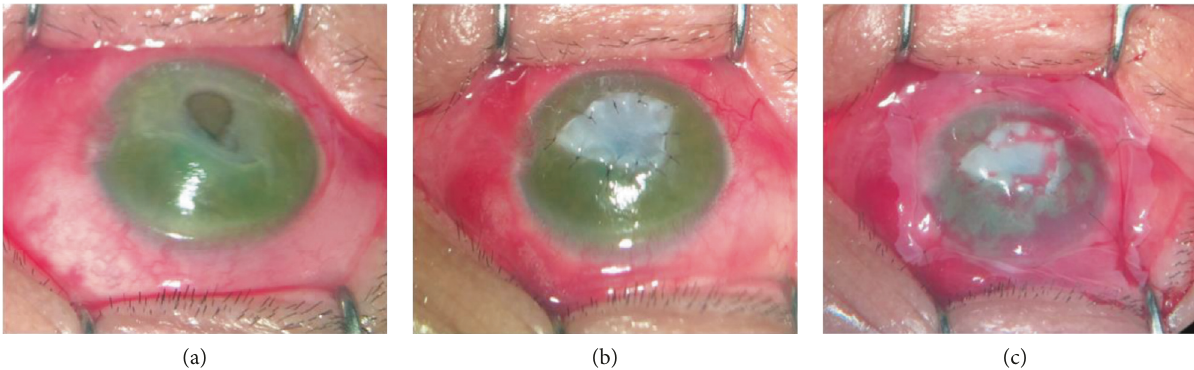
Figure 1: Surgical procedures. After the base and surrounding of the ulcer were cleaned of the necrotic tissue (a), the UCP with epithelium side facing up was trimmed to fi t the shape and depth of the ulcer and interrupted sutures were placed to anchor the UCP to the cornea (b). Finally, a large piece of the AM with epithelium side up was applied over the entire cornea